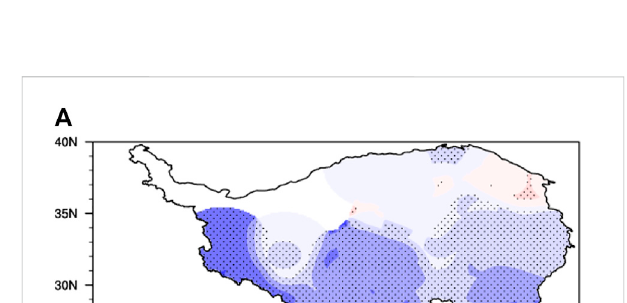
Distribution ofcorrelation coef fi cients between midsummer precipitation inSouth China and (A) thespring SH overtheTP and (B) theNiño-3 index in the preceding winter from 1979 to 2019, respectively. Cor (Precipitation, SH) and Cor (Precipitation, Niño-3) indicate the correlation coef fi cients between the spring SH over the TP, the SSTA in the preceding winter in the Niño-3 region and the midsummer precipitation, respectively. Rectangular boxes in the fi gures indicate the area of South China; the dotted areas pass the 90% signi fi cance level test.